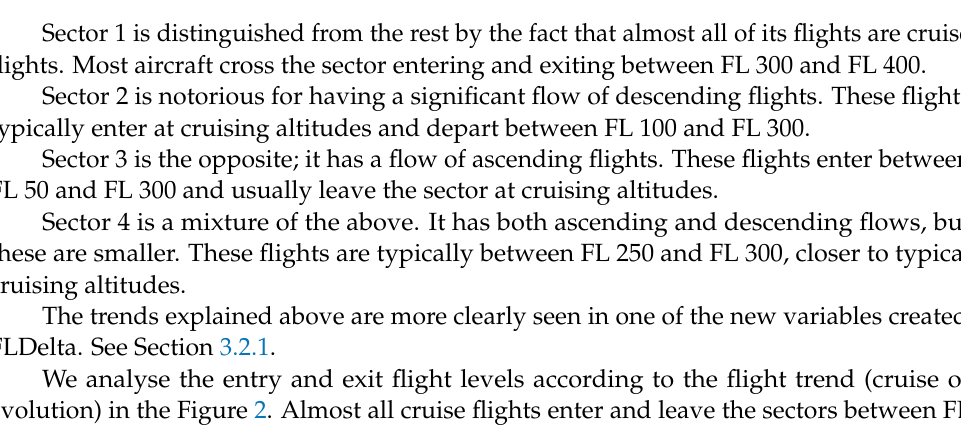
Figure 1. Entry and exit flight levels according to each sector.